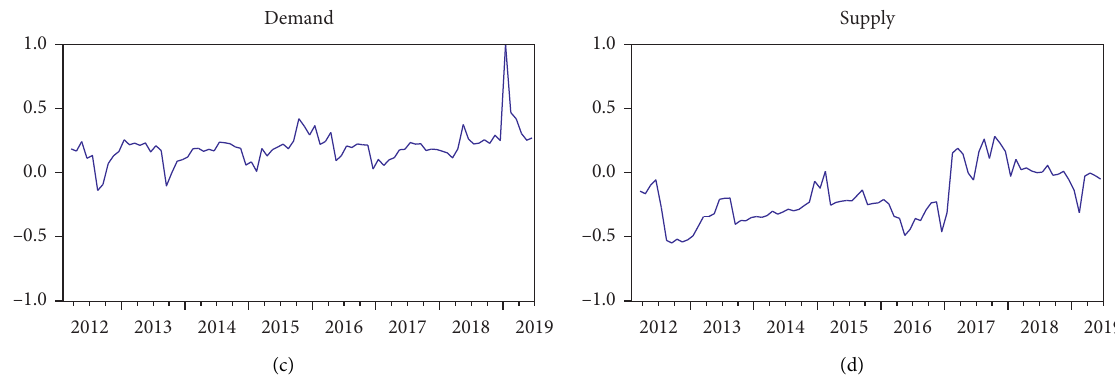
Figure 11: Dynamic correlation series from DCC-GARCH model. (a) Dynamic correlation coefficient of Brent and PHD. (b) Dynamic correlation coefficient of Brent and NHD. (c) Dynamic correlation coefficient of Brent and Demand. (d) Dynamic correlation coefficient of Brent and